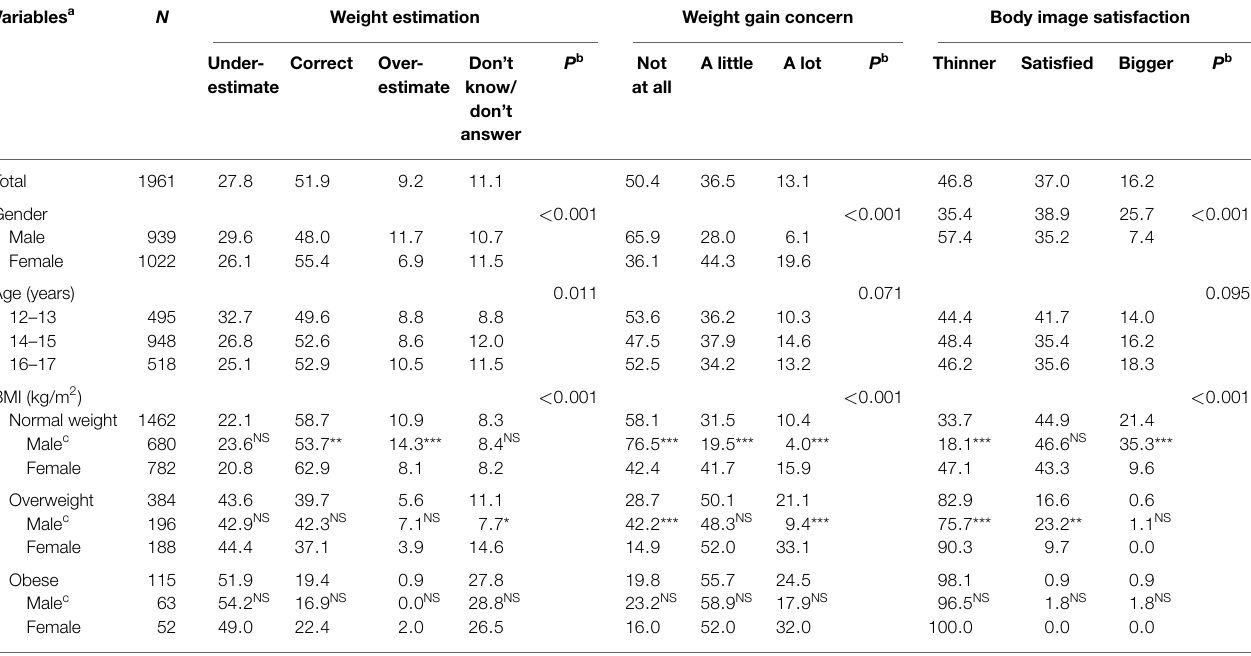
TABLE 2 | Weight estimation, weight gain concern, and body image satisfaction by gender, age, and BMI group . Variables a